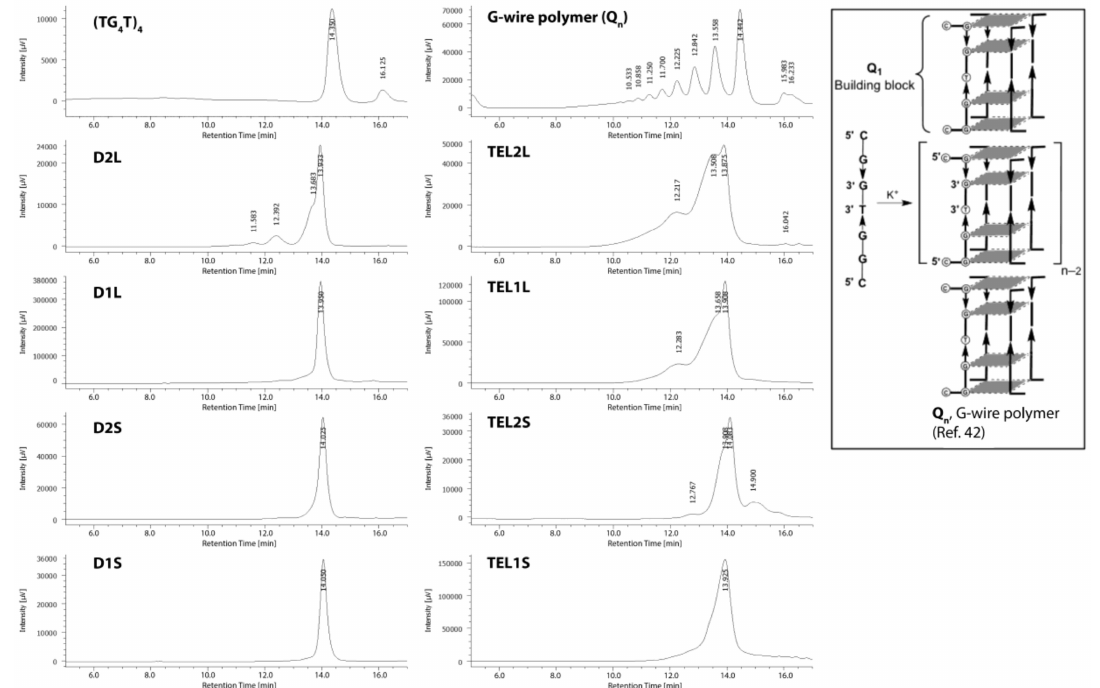
Figure 3. HPLC–SEC chromatograms of the complexes formed by DEL-(TG 4 T) 2 ( D1L , S , D2L , S ) and TEL-(TG 4 T) 4 ( TEL1L , S and TEL2L , S ) in comparison with the (TG 4 T) 4 G4 (Q 1 ) and with the Q n G-wires.